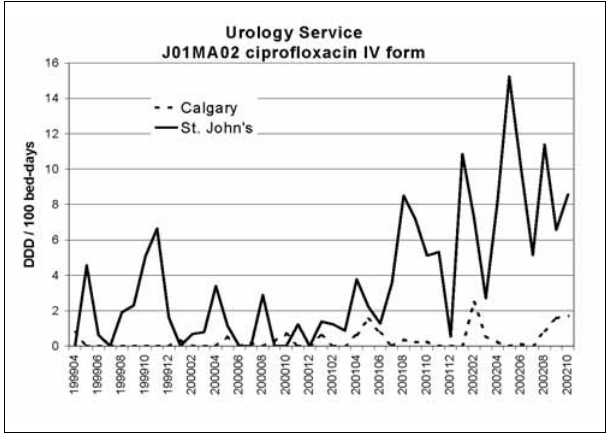
Figure 8) Comparison of consumption of ciprofloxacin (J01MA02) in the Urology Service of the Healthcare Corporation of St John’s with the Urology Service of the Calgary Health Region from April 1999 to October 2002 in monthly data points. DDD Defined Daily